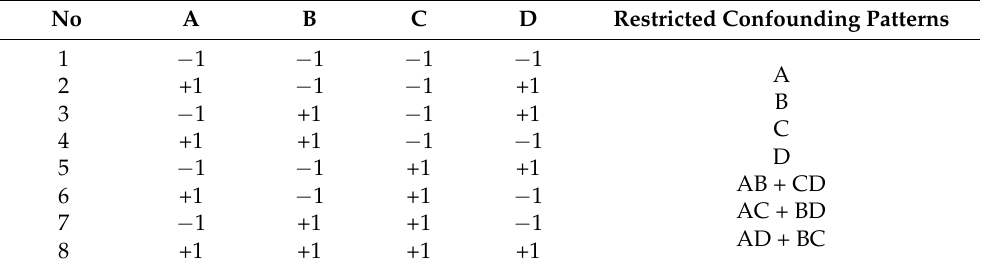
Table 3. Matrix of